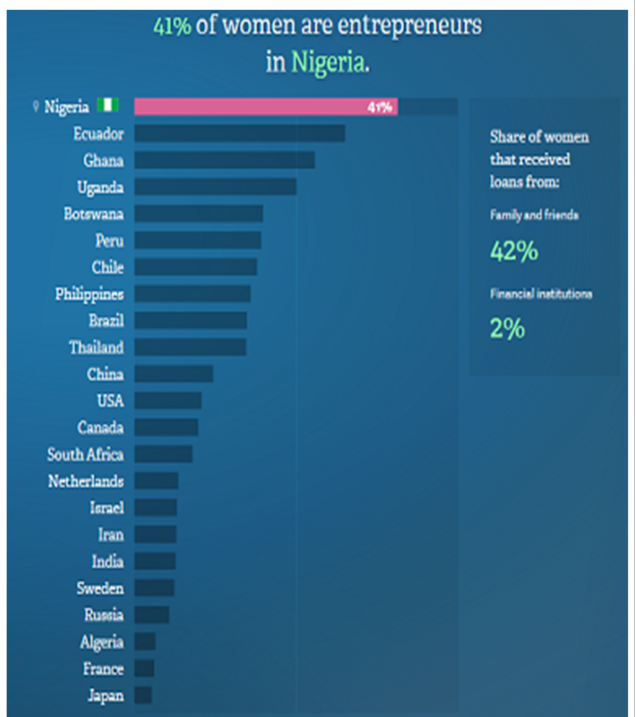
Figure 1. Women entrepreneurs in Nigeria